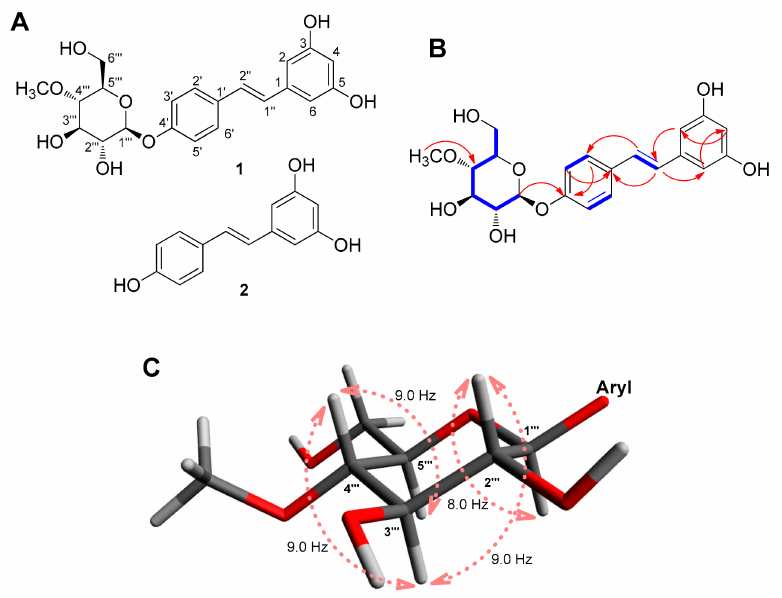
Figure 1. ( A ) Chemical structures of resvebassianol A ( 1 ) and RSV ( 2 ). ( B ) Key 1 H- 1 H COSY (blue bold lines) and HMBC (red arrows) correlations of 1 . ( C ) Coupling constant analysis of 4- O -methyl-